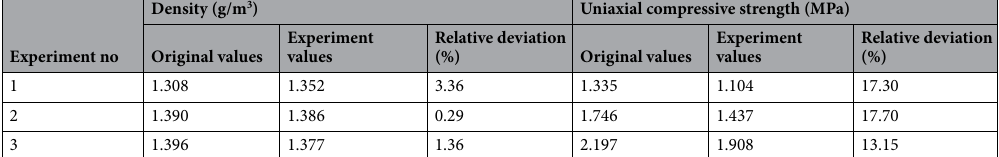
Table 9. Comparison of experiment values and original values of density and uniaxial compressive strength of similar materials.